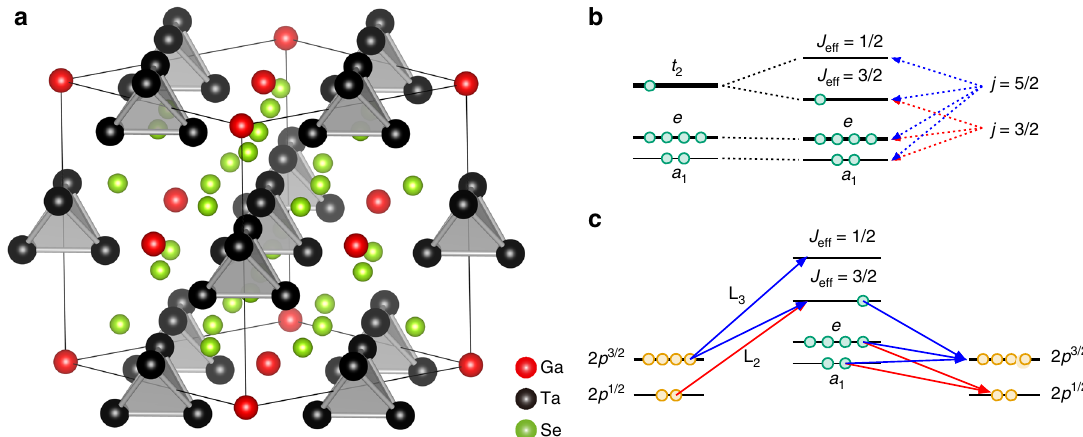
Fig. 1 Crystal structure, MO levels, and RIXS process in GaTa 4 Se 8 . a The crystal structure of GaTa 4 Se 8 (cubic F 43 m ). The red , black and green spheres represent Ga, Ta and Se atoms, respectively. The Ta 4 tetrahedron clusters (shaded in gray ) form a face-centered-cubic lattice. b The MO energy levels of Ta 4 cluster near the Fermi level ( E F ). Due to the SOC, three-fold degenerate t 2 MO states split into Kramers quartet ( J eff = 3/2) and doublet ( J eff = 1/2) MO states. The former has the mixed character of the atomic j = 3/2 and j = 5/2, whereas the latter is branched off from the j = 5/2. c Schematic diagram for RIXS processes involving the J eff = 1/2 and J eff = 3/2 MO states. The low-energy dipole allowed non-elastic L 2 - and L 3 -edge RIXS processes are indicated by red and blue arrows , respectively. Ta 2 p electrons in p 1/2 and p 3/2 core states are denoted by orange circles and 5 d electrons occupying MO states near E F are represented by green circles . Since 2 p 1/2 → J eff = 1/2 transition is forbidden, orbital excitations involving the J eff = 1/2 MO states are absent in the L 2 -edge RIXS. Therefore, only two elementary processes are allowed for the inelastic L 2 -edge RIXS. This should be contrasted with the inelastic L 3 -edge RIXS where fi ve different processes are expected in low-energy